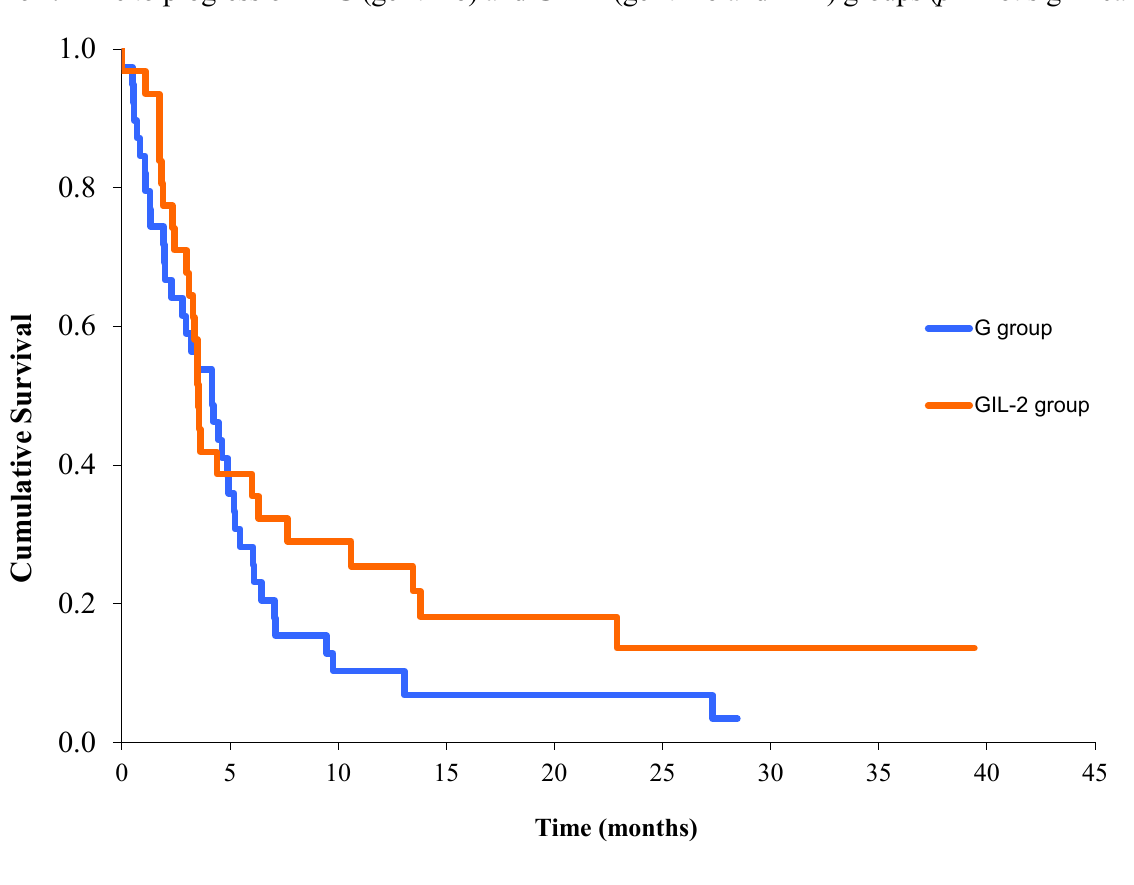
Figure 1. Time to progression in G (gefitinib) and GIL-2 (gefitinib and IL-2) groups ( p = not